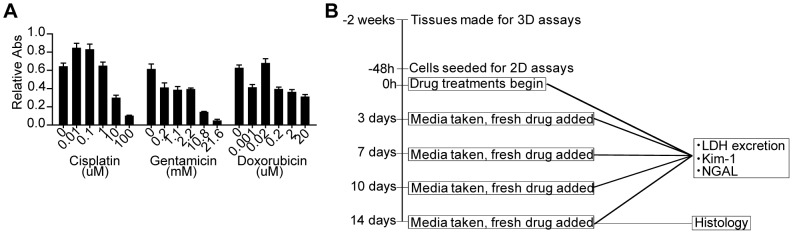
Drug treatment range and strategy.(A) NKi-2 cells were subjected to a range of drug concentrations for 48 hours and cell proliferation was determined by reduction of MTT. n  =  6. (B) Schematic of the process of drug treatment followed for both the NKi-2 cells and the 3D tissues.